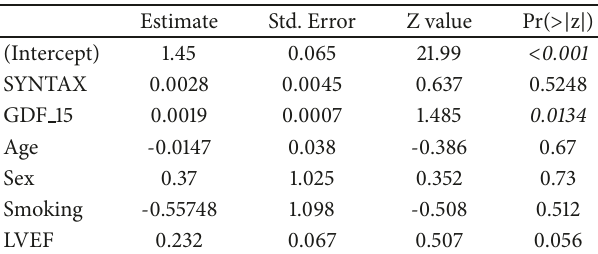
Table 3: Logistical regression analysis of the myocardial infarction happening in 409